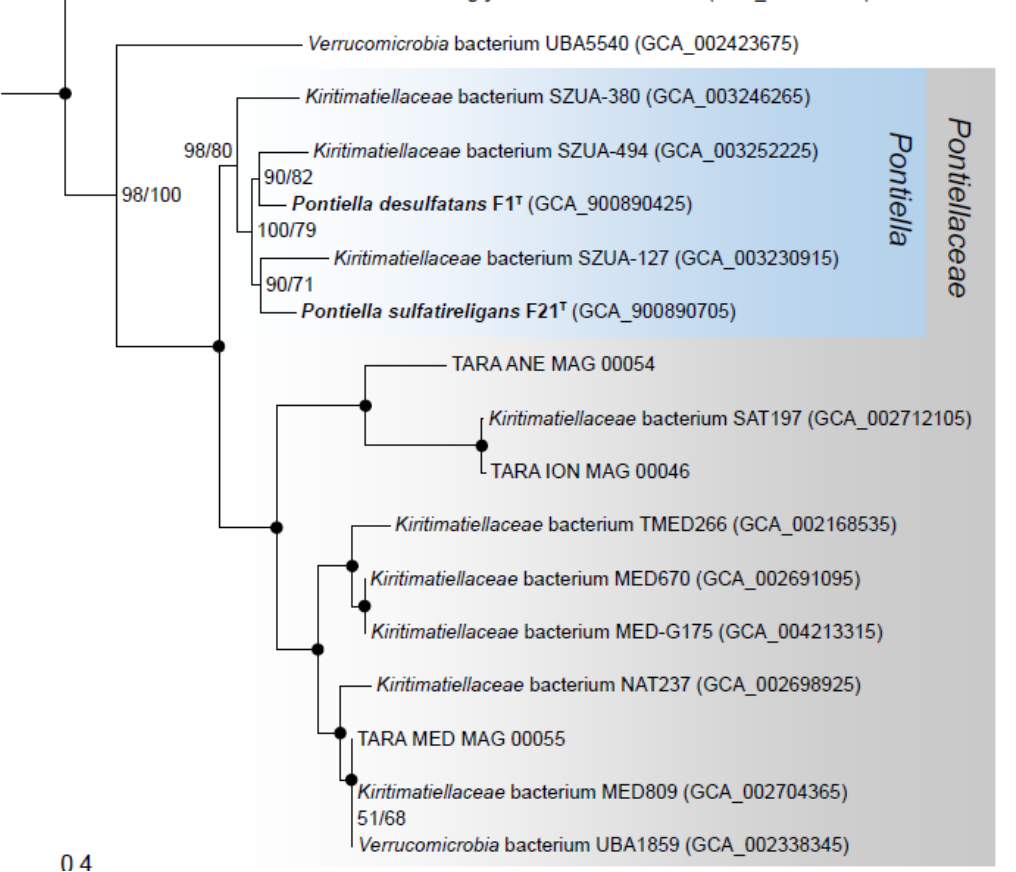
Figure 6. Maximum-likelihood phylogenetic tree of the members of the order Kiritimatiellales constructed from concatenated alignments of single-copy genes. Two Kiritimatiellae genomes outside of the Kiritimatiellales order (GTDB order UBA8416) were taken as outgroup and were omitted from the figure. Branch support is indicated with SH-like approximate likelihood ratio test values and ultra-fast bootstraps values, in that order. Black circles indicate support values of 100/100. The scale bar indicates substitutions per site. All cultured members are highlighted with bold font. The proposed novel genus and family are shaded in blue and grey, respectively. Since the UBA5540 and the SAT197 metagenome-assembled genomes (MAGs) share only 48% amino acid identity (AAI), we tentatively excluded MAG UBA5540 from the proposed novel family . MAG UBA5540 represents the uncultivated MSBL3 cluster based on the classification of its 16S rRNA gene using Silva ACT [56] , and thus may represent an additional novel family within the Kiritimatiellales . NCBI accession numbers are indicated between parentheses, except for TARA oceans MAGs from Delmont , et al. [38] which can be accessed from https://doi.org/10.6084/m9.figshare.4902923 . Unlike K. glycovorans , strains F1 T and F21 T synthesized menaquinones (Table 2). Both strains